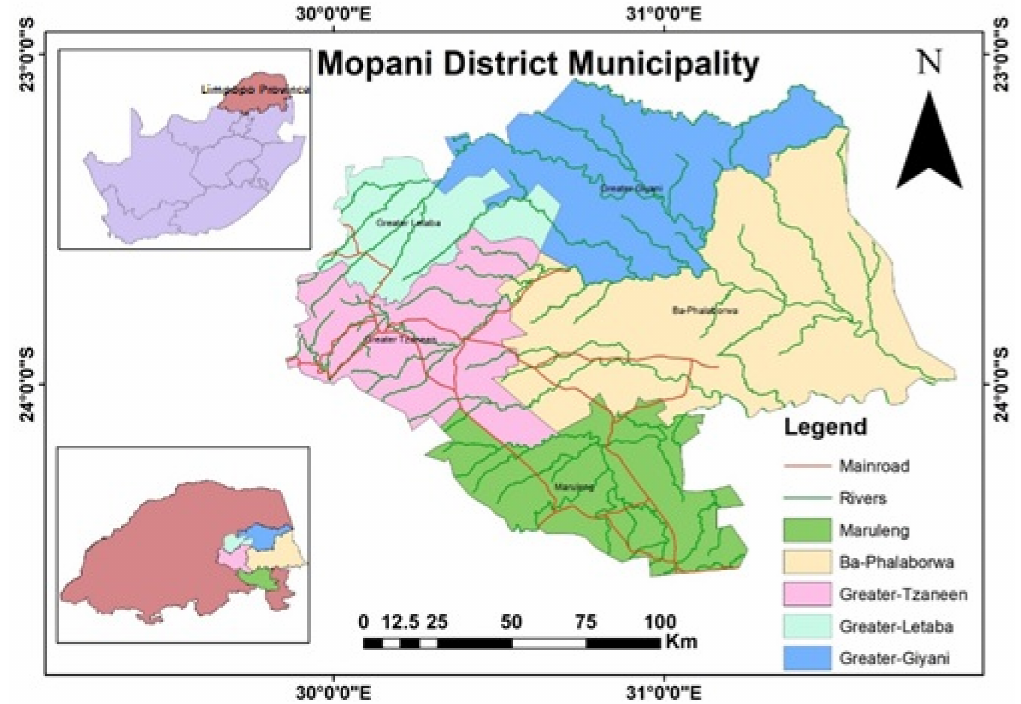
Climate 2021 , 9 , x FOR PEER REVIEW Figure 1. Map showing the location of Mopani District Municipality, Limpopo Province, in the northeast of South Africa.